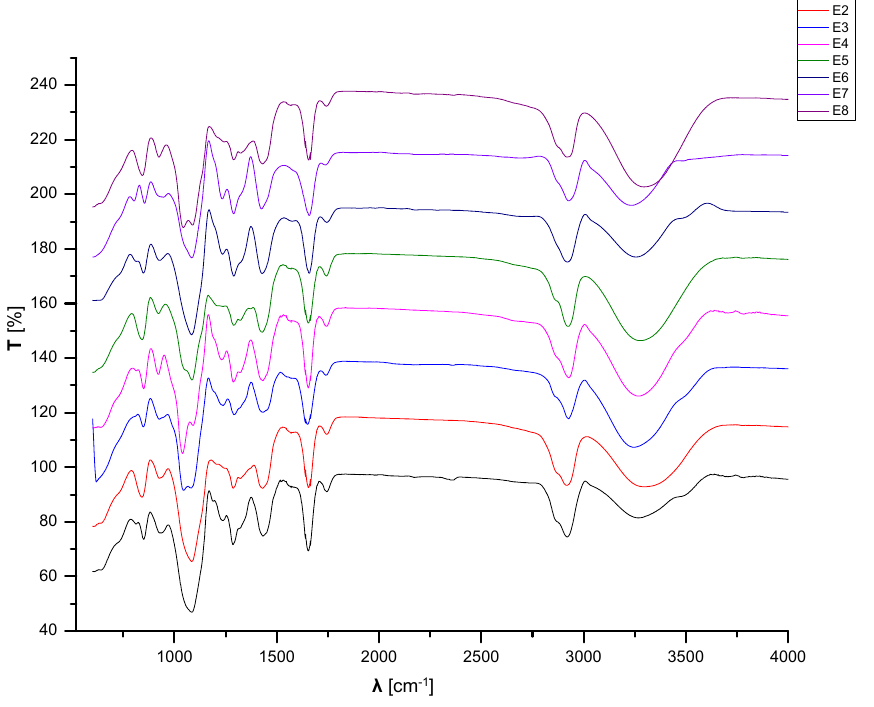
Figure 9. FTIR spectroscopy spectra of the E1–E8 samples.